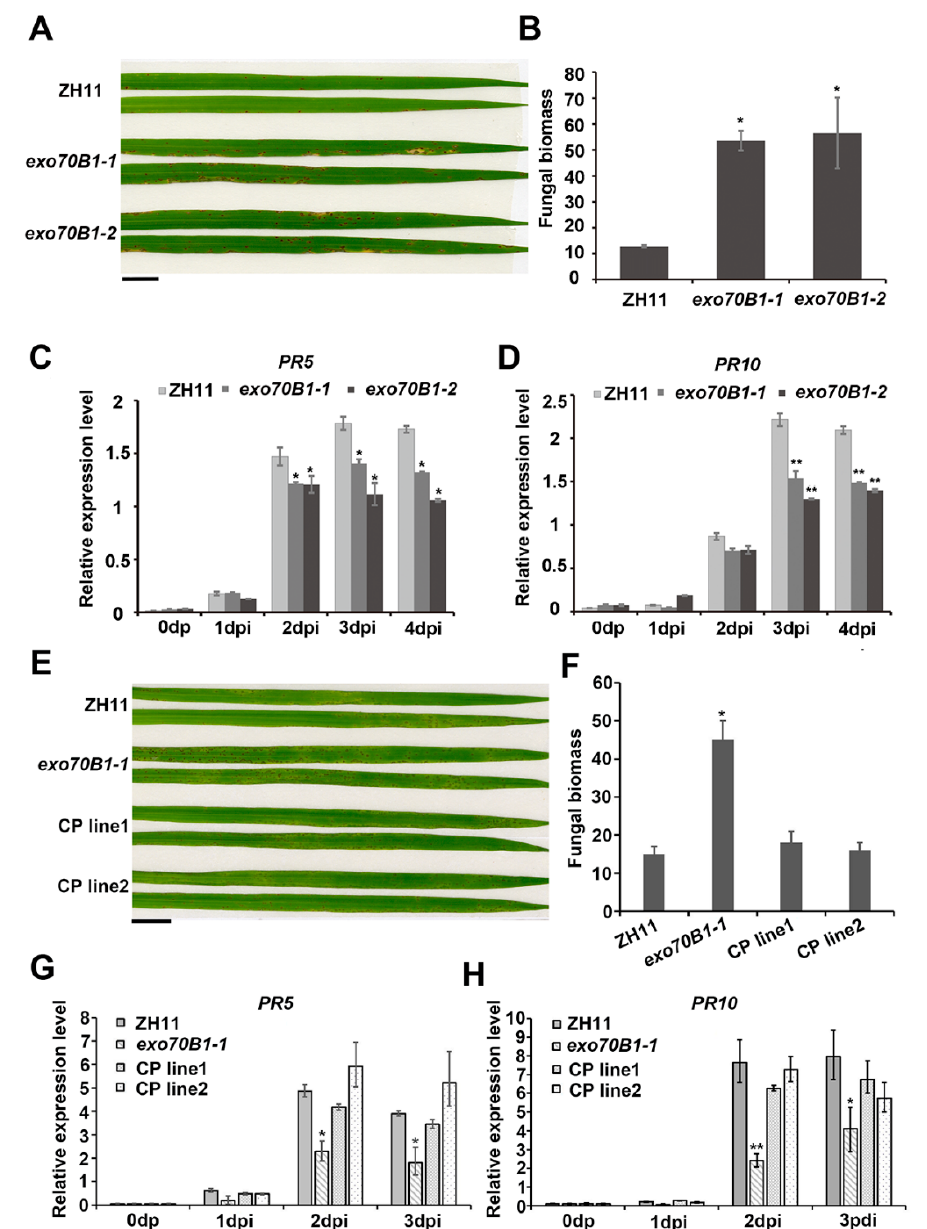
Figure 4. Knocking out Exo70B1 decreased plant resistance to M. oryzae . ( A ) exo70b1-1 and exo70B1-2 produced more diseased lesions compared to the wild type after inoculation with Guy11 using the spraying method. Bar = 1 cm. ( B ) Relative fungal amounts as determined by qPCR of the M. oryzae Pot2 gene compared to the Ubiquitin gene and compared to ZH11. Data represent the mean and standard deviation of three biological replicates. Three technical replicates for each biological sample were used. Asterisks represent significant differences (* p < 0.05, Student’s t -test). ( C , D ) Transcripts of Os PR5 and Os PR10 were both significantly downregulated in exo70b1-1 and exo70B1-2 compared to the wild type. Data represent the mean and standard deviation of three biological replicates. Three technical replicates for each biological sample were used. Asterisks represent significant differences relative to wild-type ZH11 plants (* p < 0.05, ** p < 0.01, Student’s t -test). ( E ) Rice disease lesions caused by M. oryzae locally inoculated (10 5 spores/mL) on leaves of ZH11, exo70B1-1 and exo70B1-1 complementary plants (CP). Bar = 1 cm. ( F ) Relative fungal amounts of ZH11, exo70B1-1 and exo70B1- 1 complementary plants (CP). Data represent the mean and standard deviation of three biological replicates. Three technical replicates for each biological sample were used. Asterisks represent significant differences (* p < 0.05, Student’s t -test). ( G , H ) Transcripts of Os PR5 and Os PR10 were